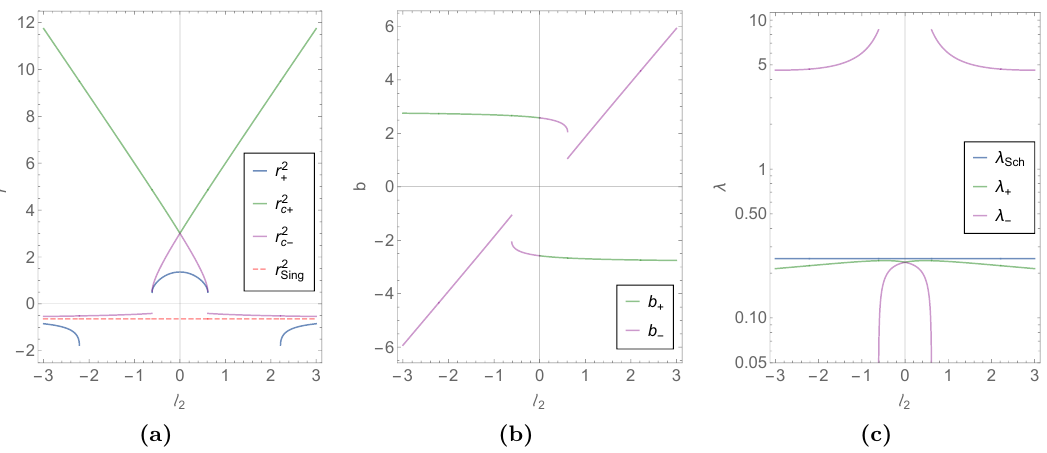
, in blue the values of r 2 , In green and purple the Figure 2. (a) In red the maximum values of r 2 + sing values of r 2 and r 2 respectively. (b) In green and purple the values of b c, + and b c, − respectively. c, + c, − (c) In green and purple the values of λ + and λ − respectively. In all plots we set M = 1 and ‘ 1 = 0 . 8